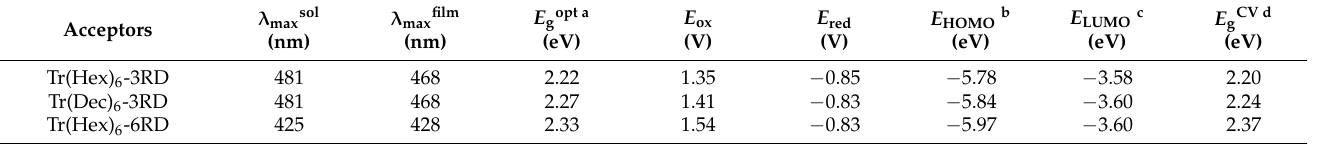
Figure 4. UV-vis absorption spectra of truxene-centered SMAs in chloroform solution ( a ), and as thin films ( b ). Table 1. Optical and electrochemical properties of truxene-centered